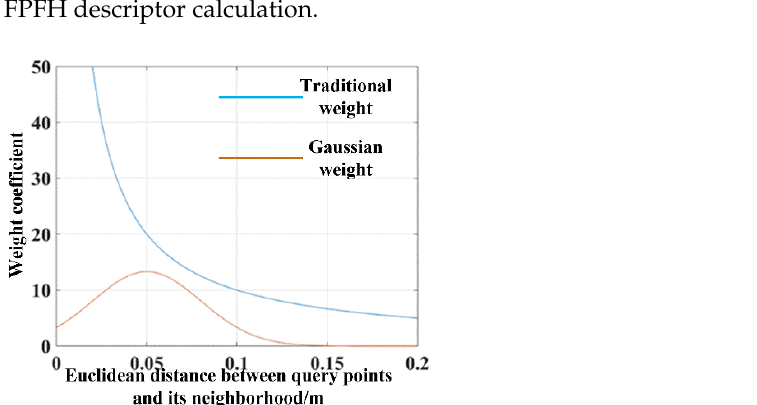
Figure 4. A neighborhood point diagram of a key point.